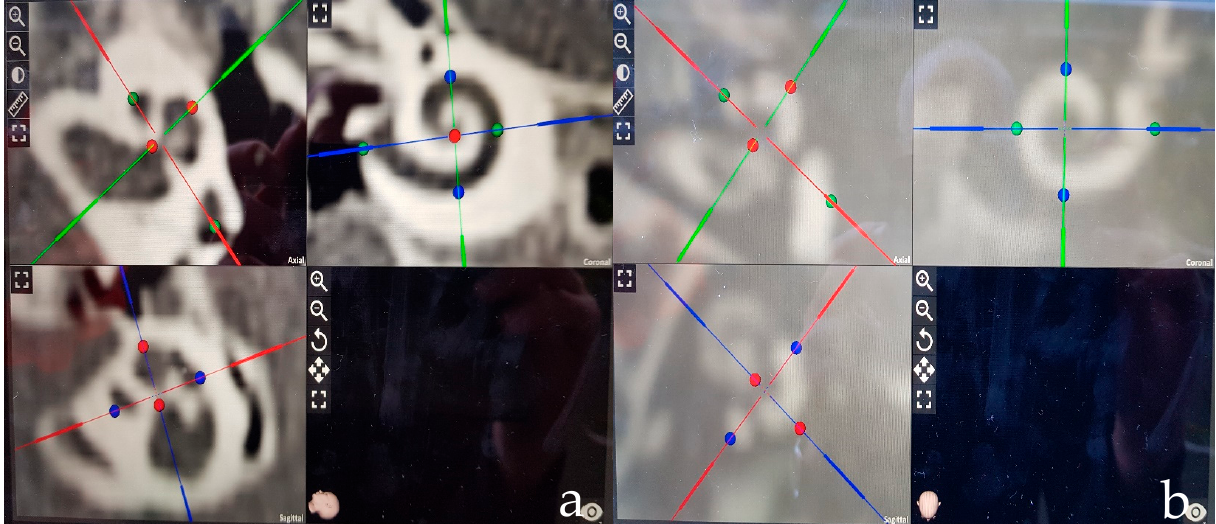
Figure 1. Measurement of cochlear parameters (diameter A = green, width B = blue, and height H = red) of a left cochlea as shown by the tablet-based Otoplan 2.0 software based on ( a ) CT data as well as ( b ) MRI data.